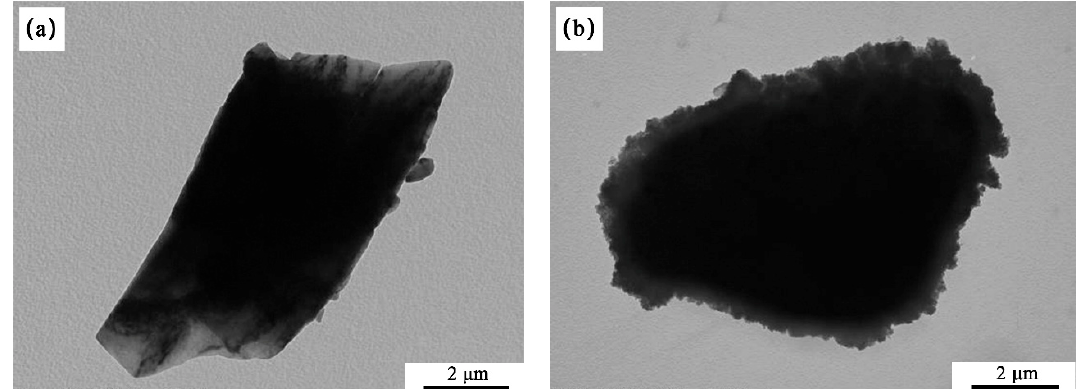
Figure 8. Transmission electron microscope (TEM) photographs: ( a ) CaF 2 powder; ( b ) CaF 2 @Al(OH) 3 composite powders.